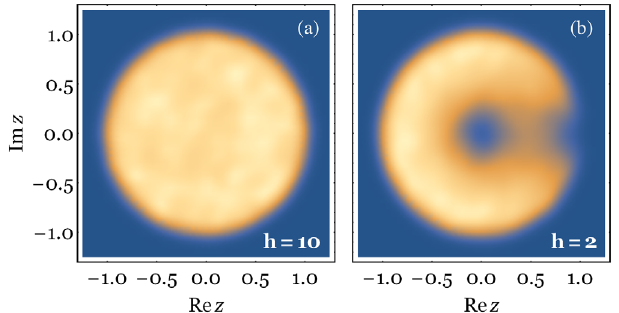
FIG. 9. Complex spacing density for the non-Hermitian Hamiltonian of Eq. (13), in the ( a ) localized and ( b ) delocalized regime, for N ¼ 18 , D ¼ 9 .